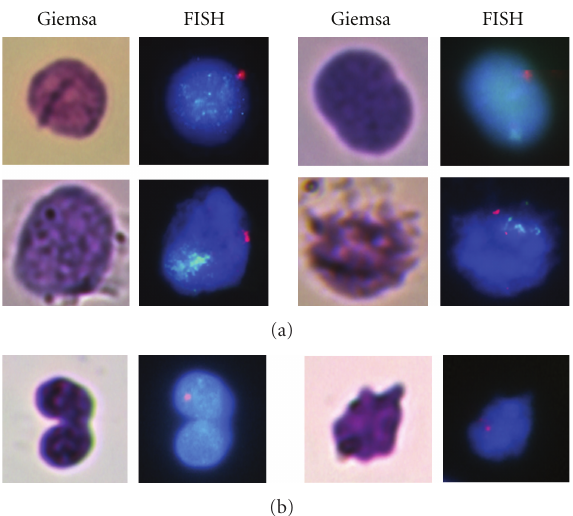
Figure 4: Giemsa and corresponding FISH photos of missed events due to inadequate hybridization (a) or nonhybridization events